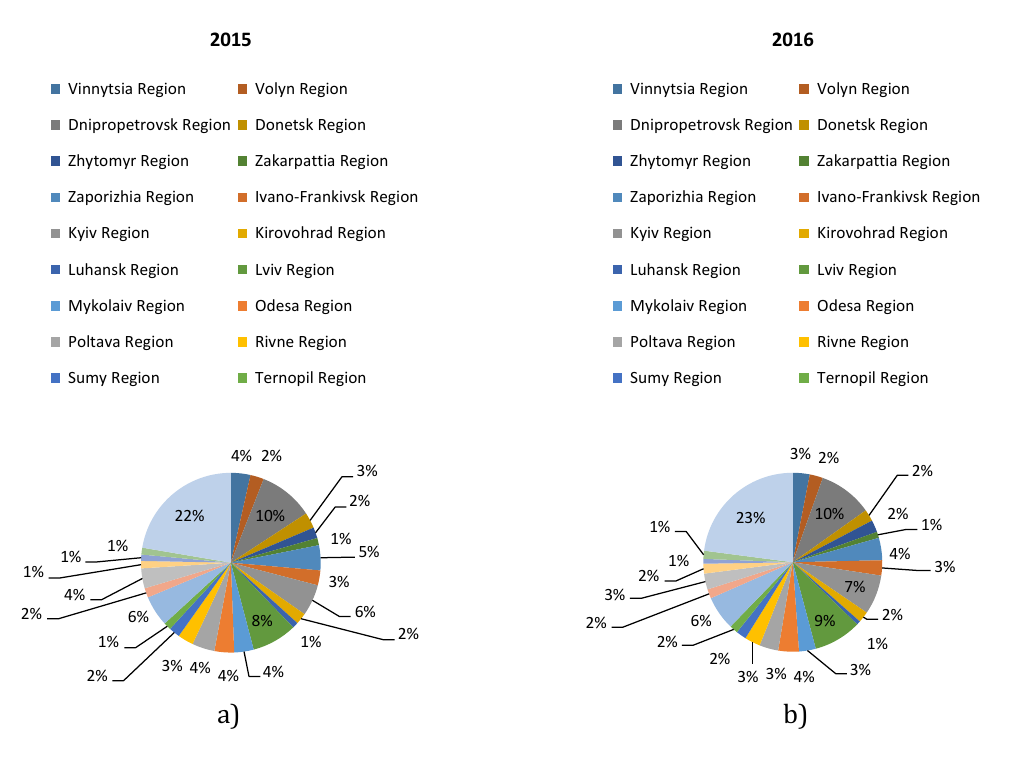
Figure 6: Structure of the construction of commercial real estate by regions